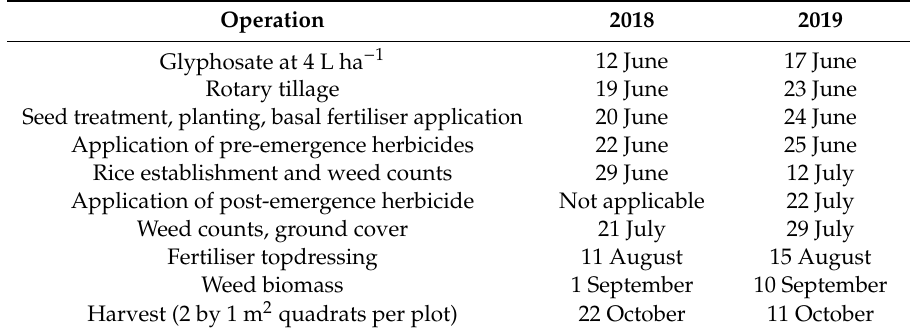
Table 2. Calendar of operations for herbicide experiments in 2018 and 2019.